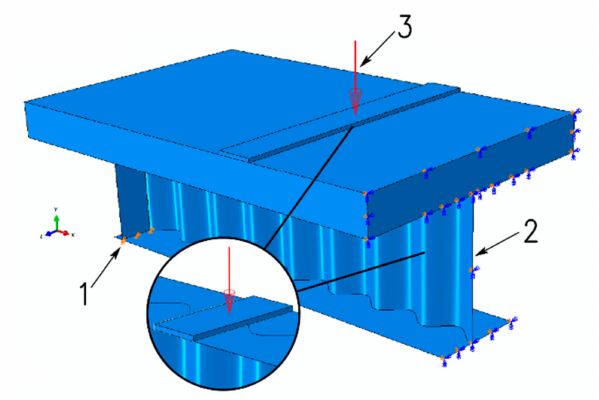
Figure 9. Boundary conditions adopted in the calculations for the considered